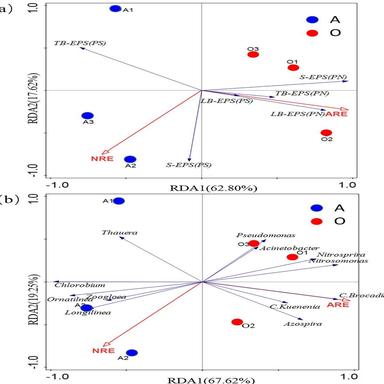
Redundancy analysis between EPS and nitrogen removal (a); between key genera and nitrogen removal (b).